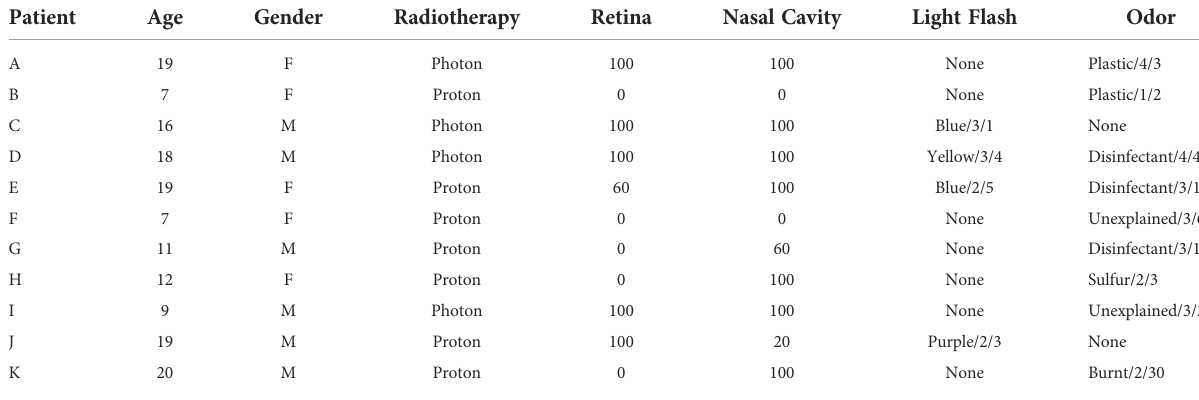
TABLE 2 Details of abnormal sensations in each patient.